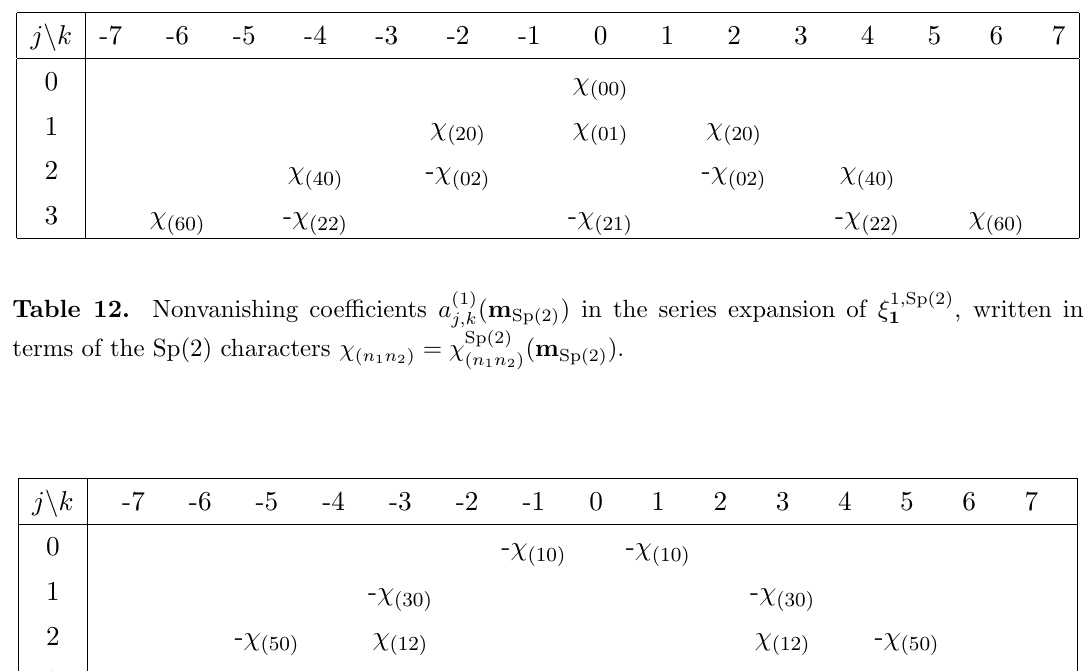
Table 13. Nonvanishing coe(cid:14)cients a (2) terms of the Sp(2) characters (cid:31)